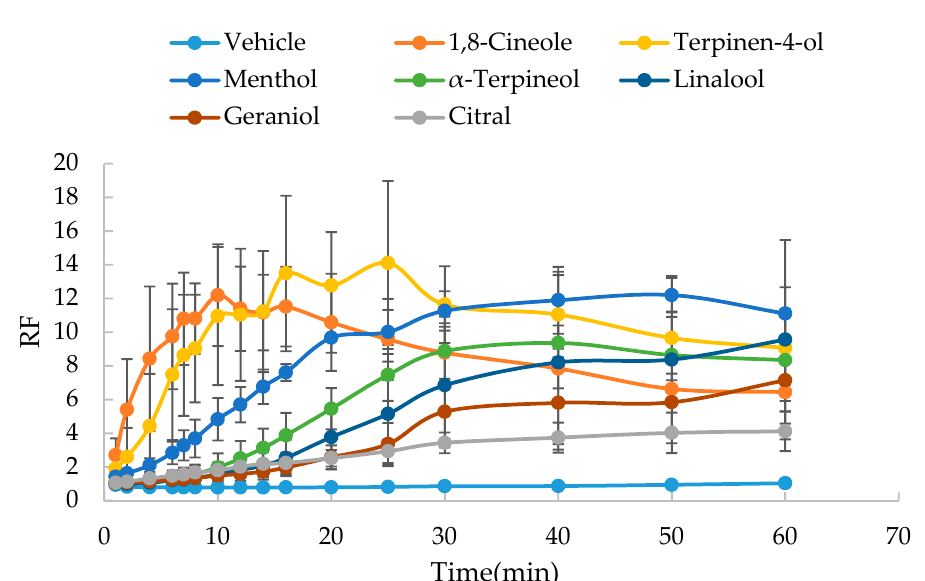
Figure 4. Effect of oxygen-containing terpenes dissolved in ethanol-PBS (1:1) on the resistance reduction factor (RF) values of excised rat skin ( n = 5).